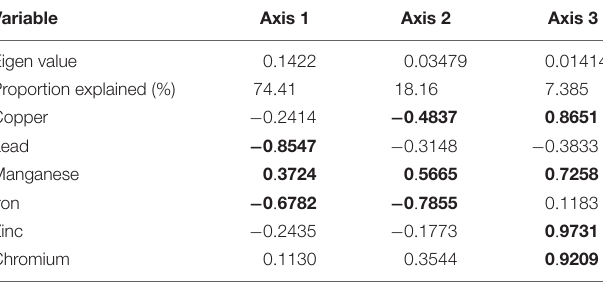
TABLE 3 | Correlations of importance of the heavy metals in the prevalence of the parasites with the first three axes of canonical correspondence analysis (CCA) in Chanchaga River, Niger